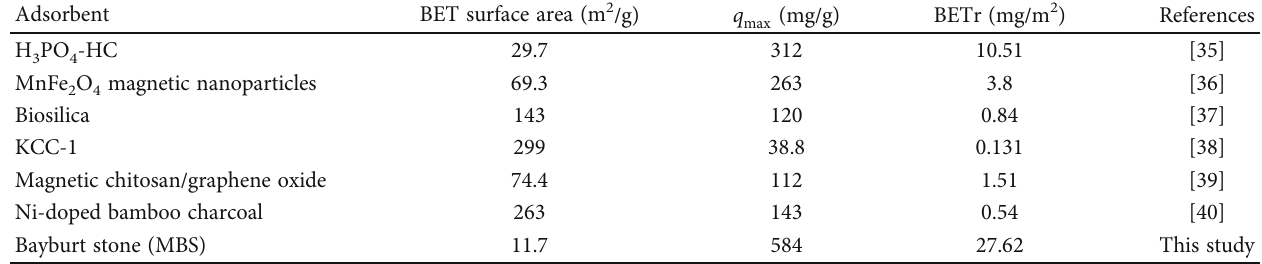
values of some modi fi ed adsorbents found in the literature and MBS. max